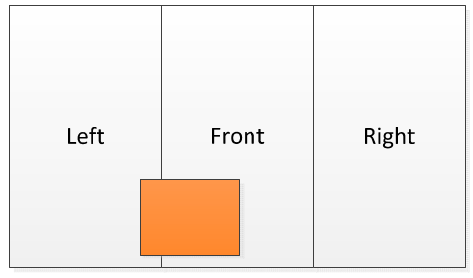
Figure 13. Directional judgment segments.